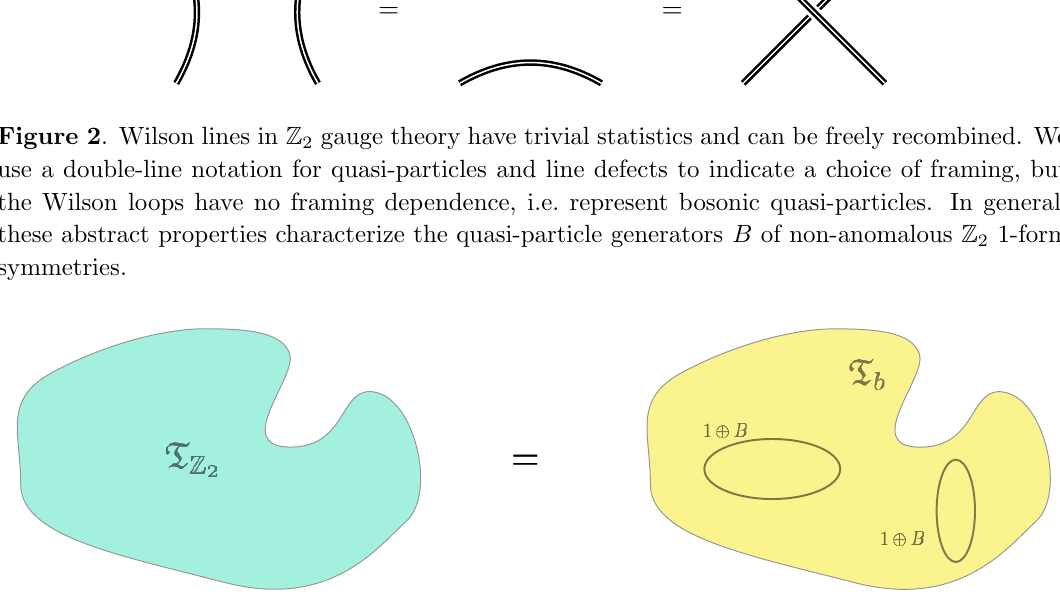
Figure 3 . A graphical depiction of the map from T b to T Z . On the right we have the partition 2 function of T b on a three-dimensional manifold, possibly decorated with Wilson line operators B along non-trivial cycles, dual to the domain walls of the previous picture. Abstractly, the choice of Wilson lines equips the manifold with a (cid:13)at connection [ (cid:12) 2 ] for a dual Z 2 1-form symmetry of T b . Summing over all choices gives back the T Z partition 2